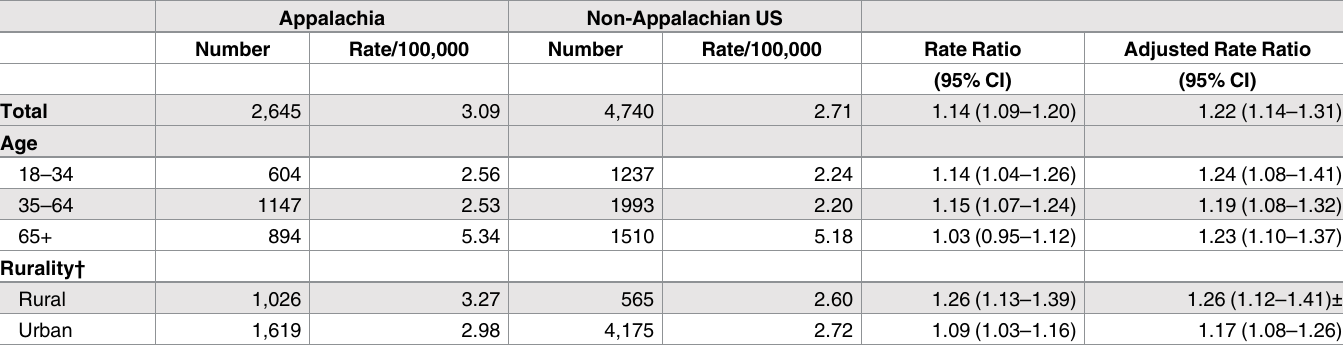
Table 2. IPV-related hospitalizations for Appalachia and non-Appalachian counties in the US,